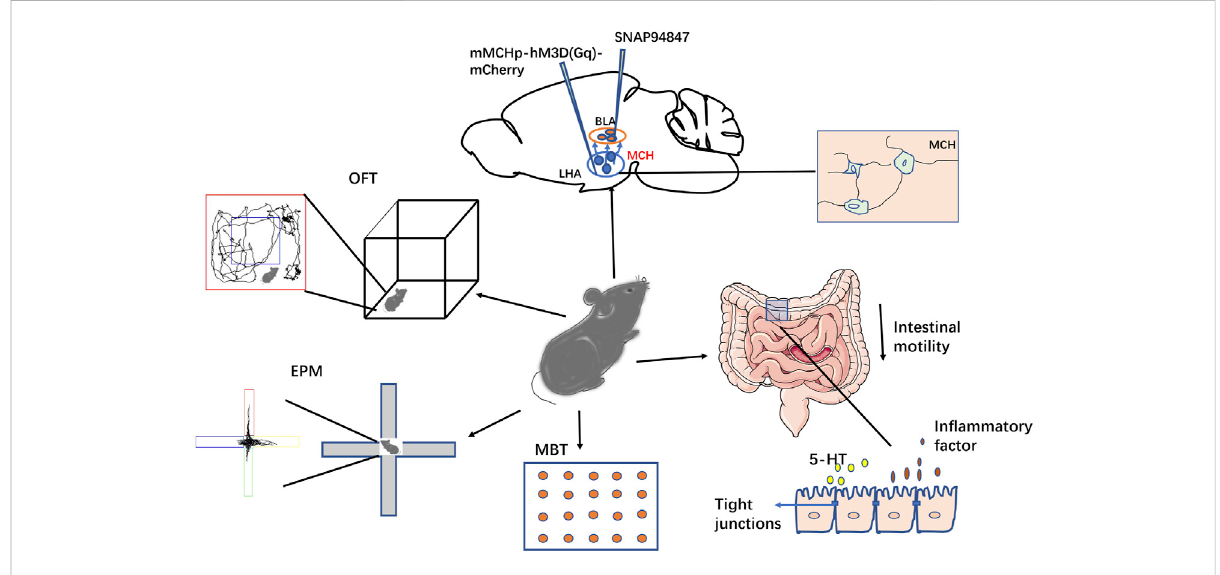
FIGURE 8 Schematic of this study. This study investigated the role of the LHA-BLA MCHergic neural pathway in regulating stress-induced anxiety and intestinal function in mice. The results showed that both injection of MCH and activation of MCH neurons in the BLA could lead to anxious-like behavior in mice, while injection of SNAP into the BLA could reduce anxious-like behavior in both activated MCH neurons and CACS model mice. In addition to the changes in their emotional behavior, the CACS model mice showed intestinal IBS-like symptoms (in fl ammation and increased permeability). SNAP treatment could improve these symptoms, suggesting that this pathway is involved in regulating emotional behavior and intestinal motility changes in anxious